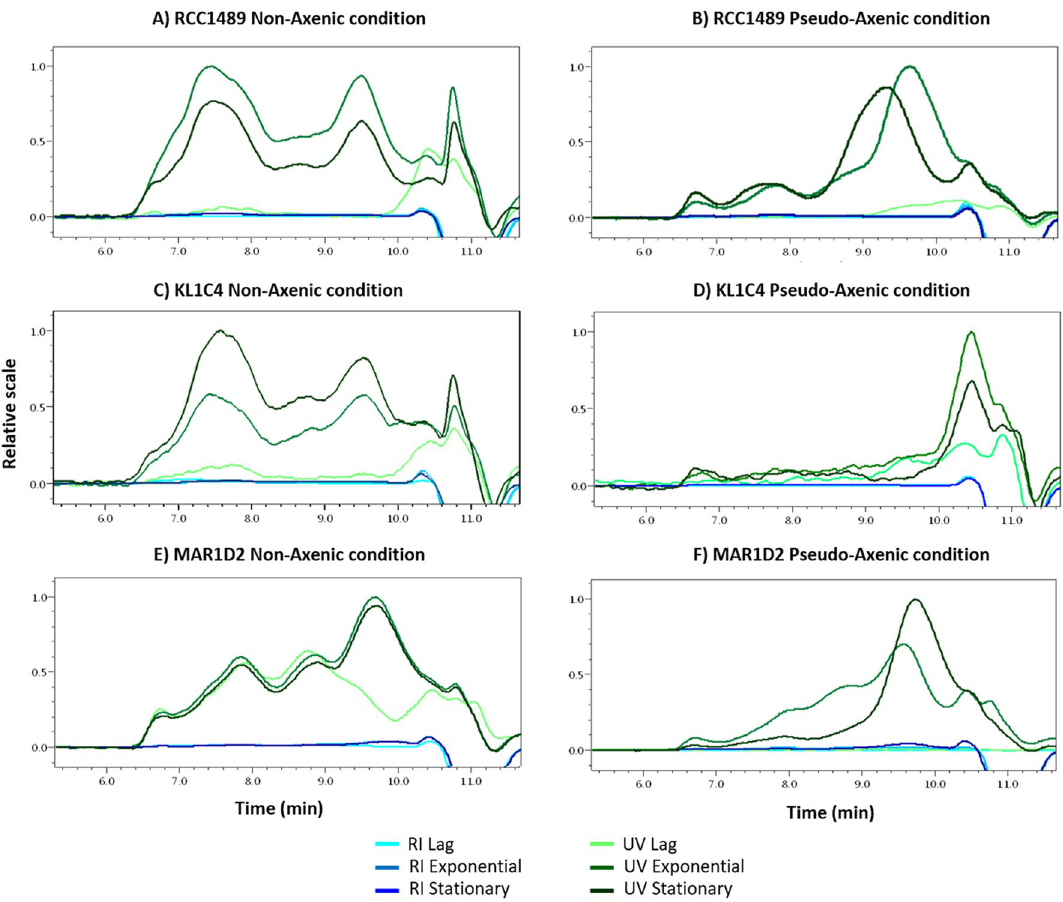
Figure 4. HPSEC profiles (with UV and RI detectors) of culture supernatants obtained for three L. chlorophorum strains, at three growth times, under non-axenic (NA) conditions: ( A ) RCC1489, ( C ) KL1C4, ( E ) MAR1D2 and pseudo-axenic (PA) conditions: ( B ) RCC1489, ( D ) KL1C4, ( F ) MAR1D2 [Astra 6.1 Software (WYATT TECHNOLOGY)]. L. chlorophorum strains RCC1489 KL1C4 MAR1D2 Condition